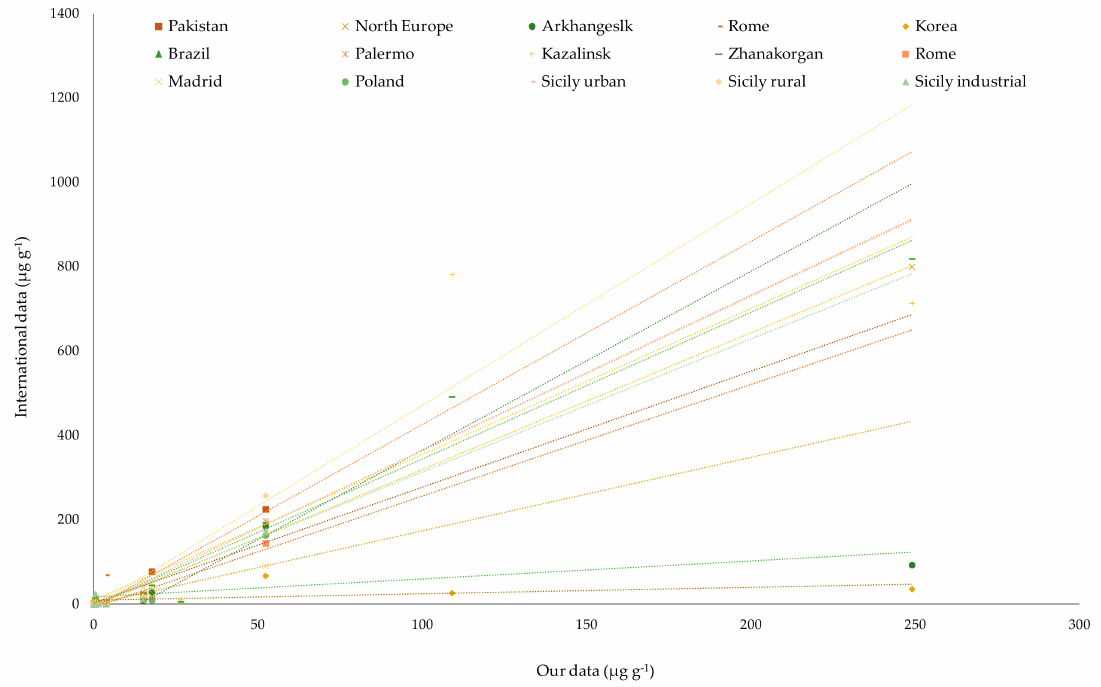
Figure 3. Correlation plots among our data and similar data determined in girl teenagers’ hair worldwide